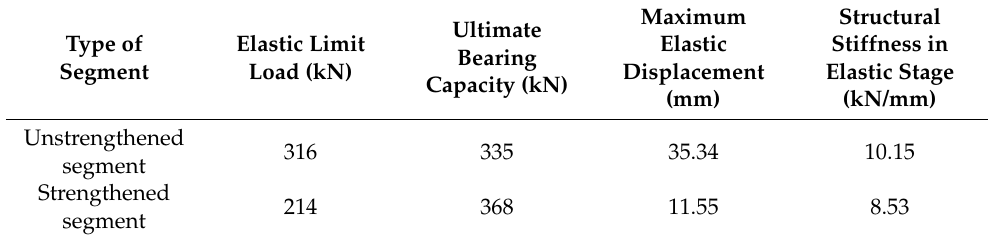
Table 4. Performance comparison between the strengthened and unstrengthened segments.